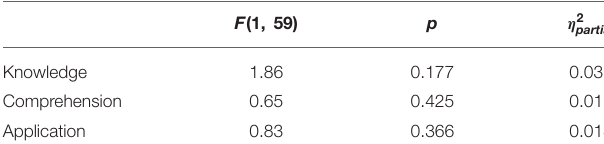
TABLE 2 | Results of the ANOVA depending on the level of learning outcome.